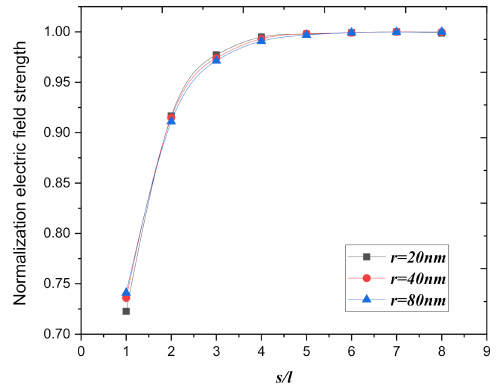
Figure 3. The normalization of the electric field strength of the graphite nanoplatelet in the middle of the array as a function of the normalization spacing of s / l , the thickness of the nano graphite sheet is chosen to be 20 nm, 40 nm, 80 nm. ( U = 200 V, d = 2.75 µ